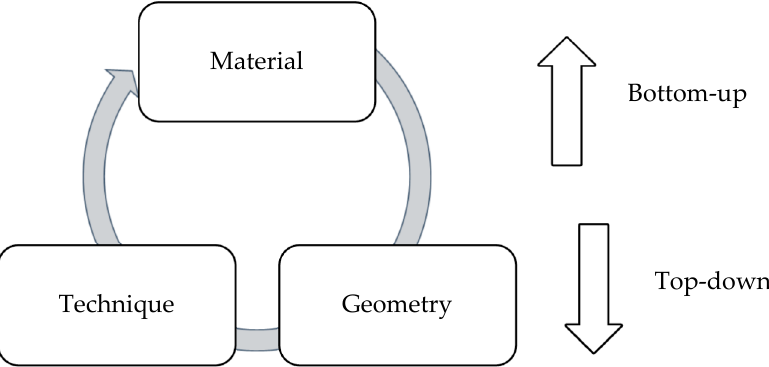
Figure 5. The recursive framework defined to work with novel materials/techniques (adapted from [2]).